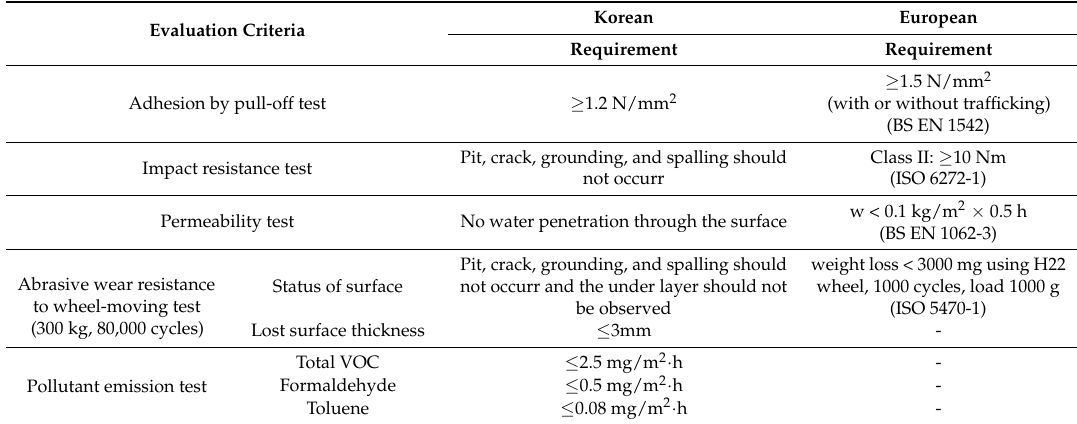
Table 1. Comparison between Korean and European standards.